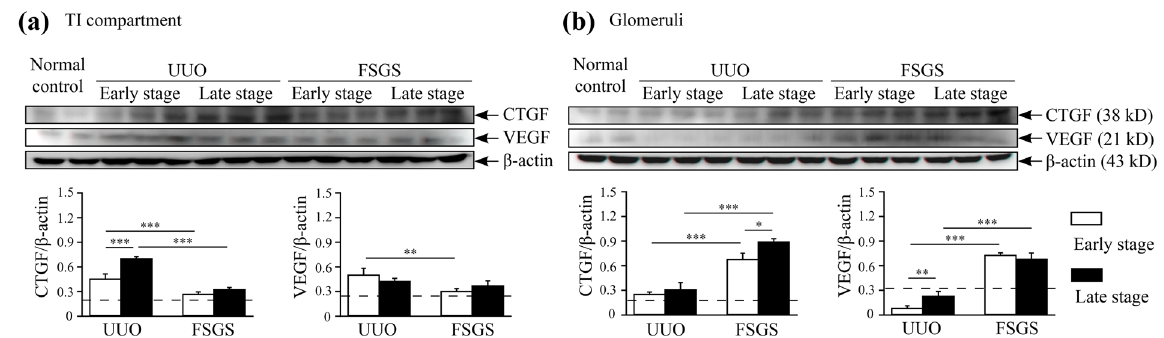
Figure 6. Correlation between the expression levels of angiogenesis-related cytokines and the renal microvasculature. ( a ) The levels of CTGF and VEGF proteins in the renal TI lesions. ( b ) The levels of CTGF and VEGF proteins in the glomeruli. β -actin was used as the internal control. The horizontal dashed line indicates the level of the normal control mice. UUO-unilateral ureteral obstruction; FSGS-focal segmental glomerulosclerosis; CTGF-connective tissue growth factor; VEGF-vascular endothelial growth factor; TI- tubulointerstitial. n = 7 mice per group. * p < 0.05, ** p < 0.01, *** p <